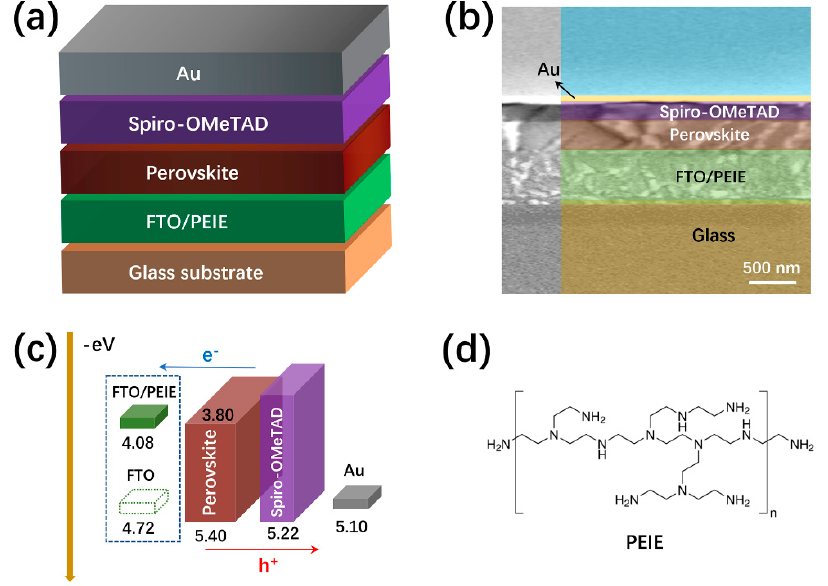
Figure 1. ( a ) Schematic device structure of the PSCs; ( b ) Cross-sectional SEM image of a PSC; ( c ) schematic energy levels of the functional layers involved in the PSCs; ( d ) chemical structure of PEIE.